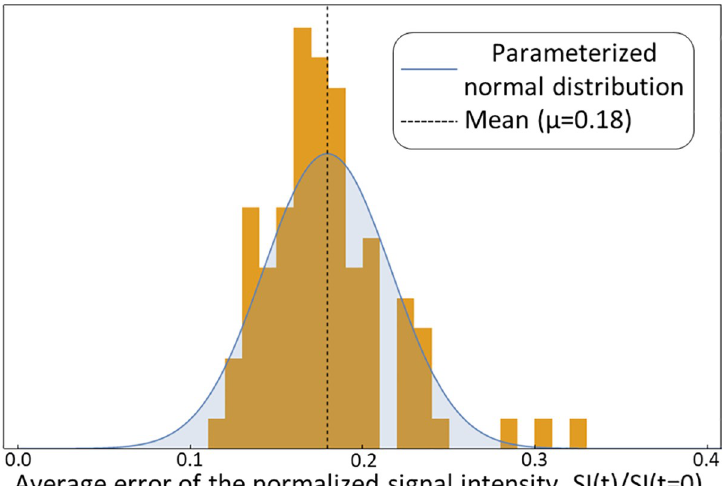
Fig 6. Estimation of the lower limit of data uncertainty. Histogram of the average uncertainty of the normalized signal intensity in the liver and spleen regions of interest, with one entry per patient. The blue bell curve shows the fitted normal distribution, which indicates a lower limit of uncertainty of